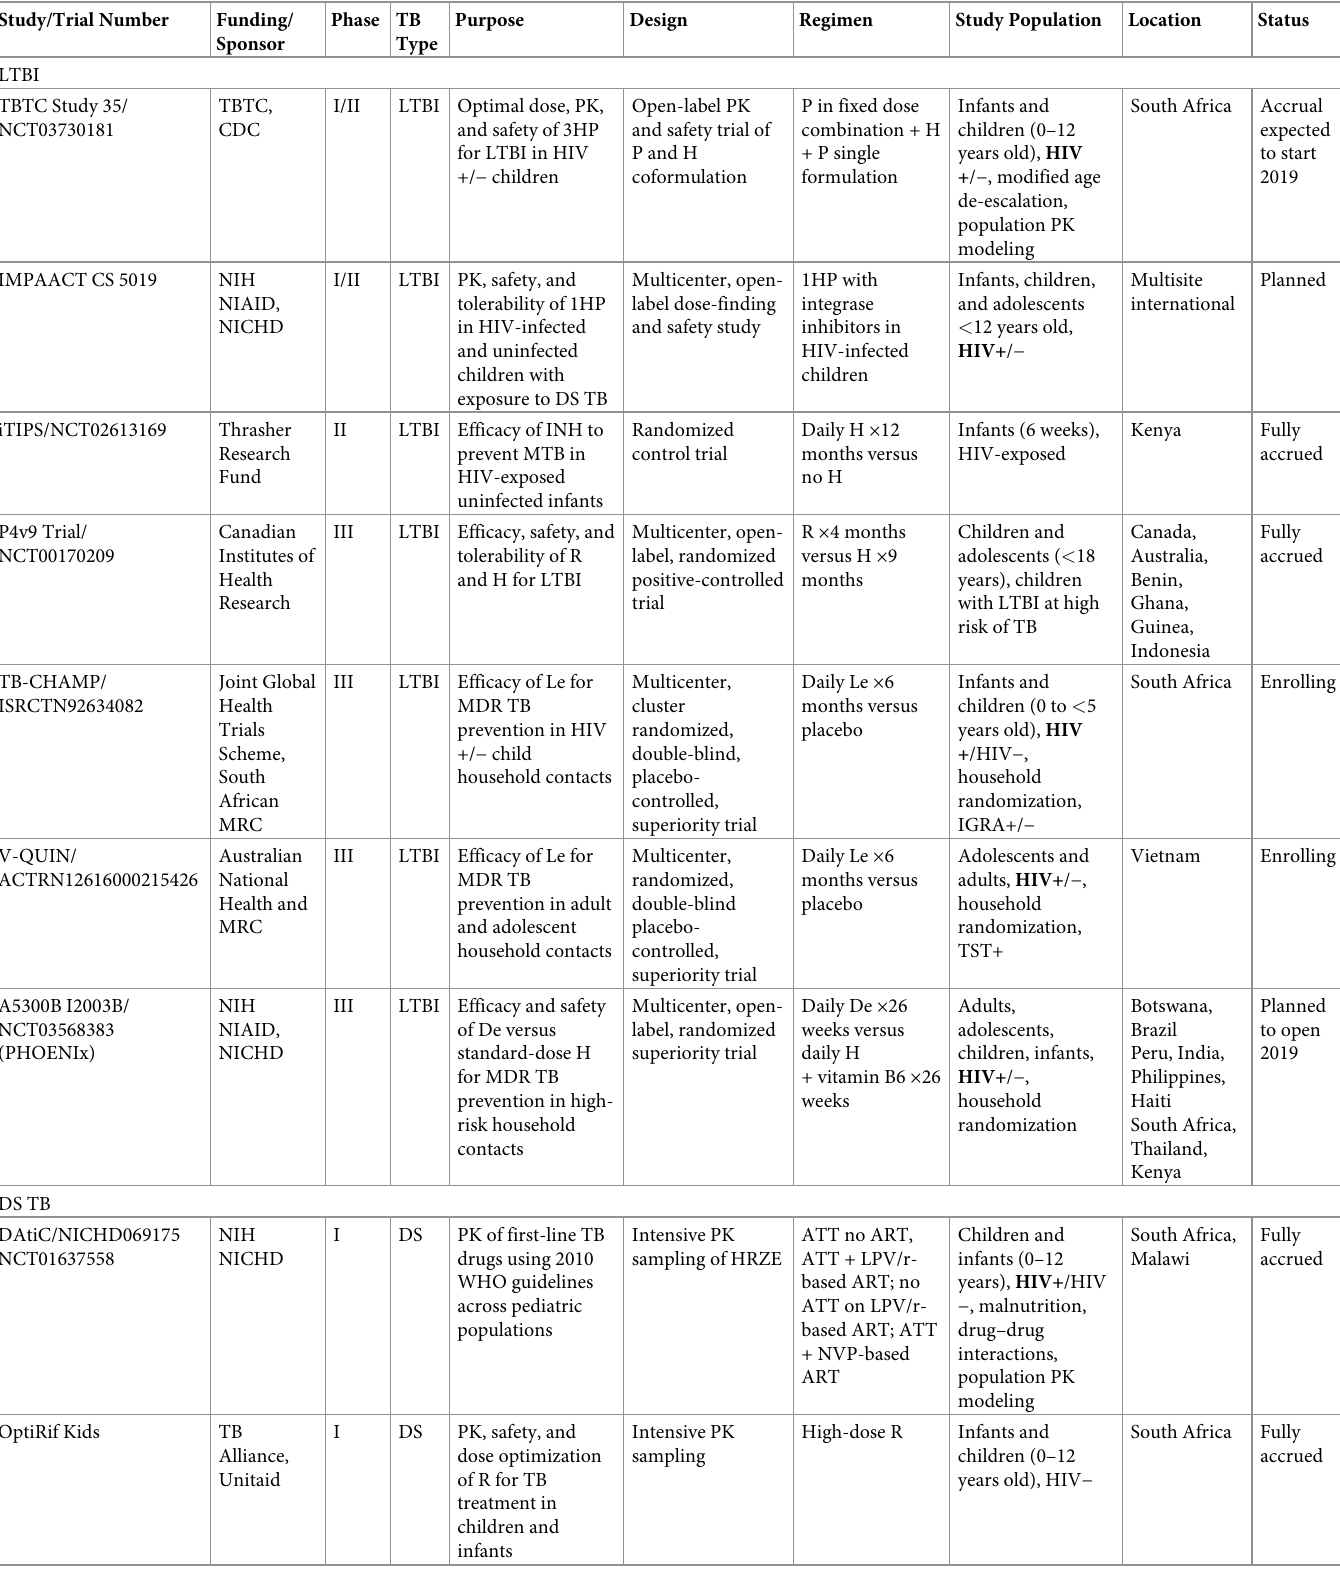
Table 3. Ongoing and planned TB clinical trials in children (as of December